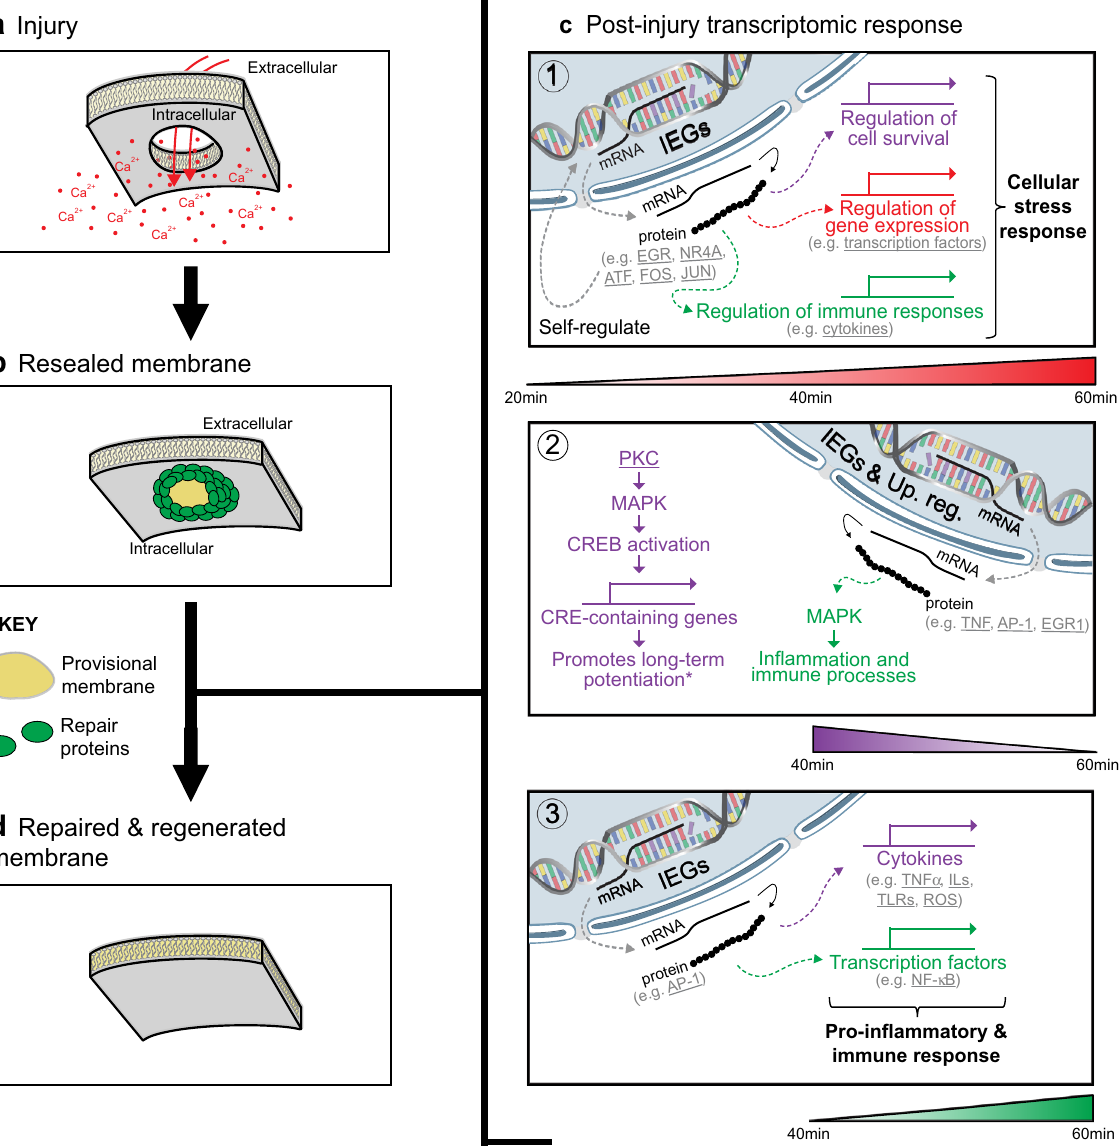
Figure 4. Short-term transcriptomic response following PM injury. ( a ) Injury at the PM results in Ca 2+ influx. ( b ) Membrane repair mechanisms are rapidly activated and result in immediate PM repair to halt the influx of Ca 2+ and outflux of intracellular components (e.g. by forming a provisional patch membrane). ( c )